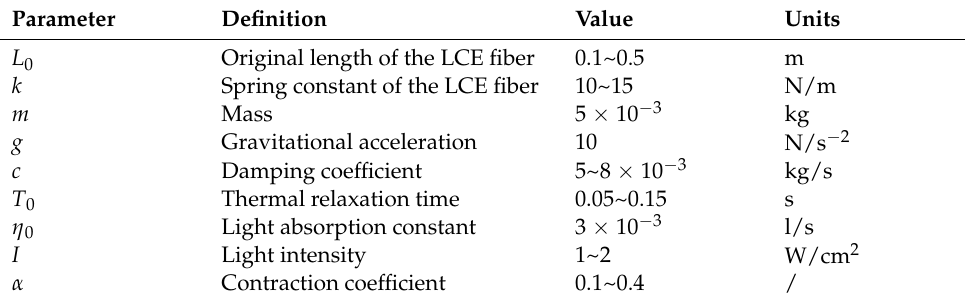
Table 1. Material properties and geometric parameters.